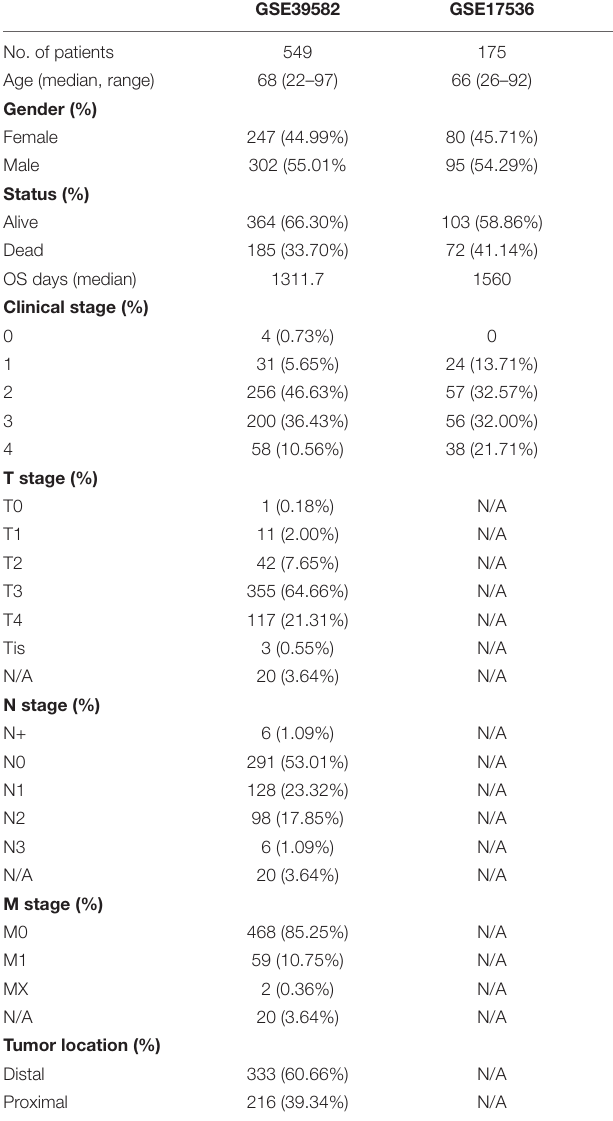
TABLE 1 | Clinical features of the CC patients involved in this